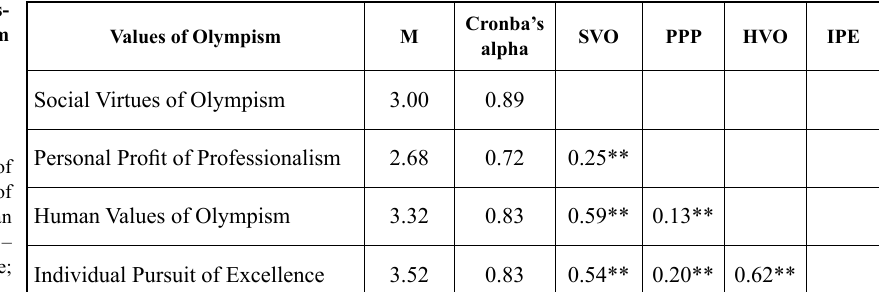
Note . SVO – social virtues of Olymism; PPP – personal profit of professionalism; HVO – human values of Olympism; IPE – individual pursuit of excellence; M – mean score; ** – p <